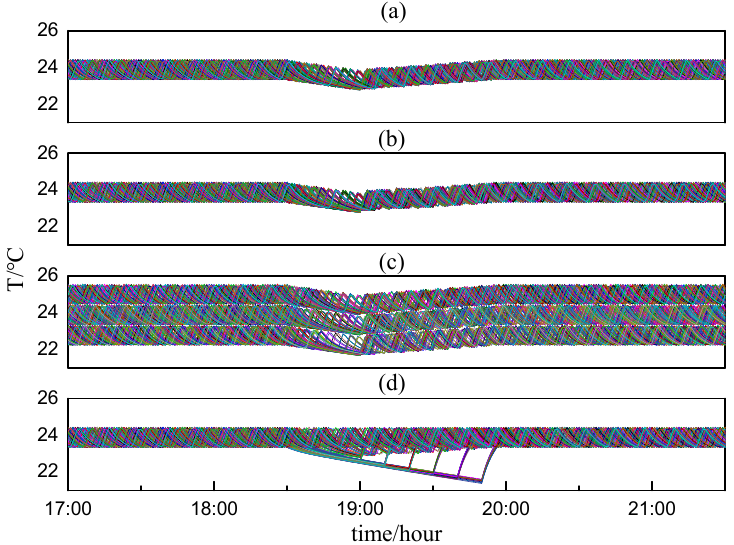
Figure 13. The indoor temperature curves of 200 units randomly selected from the aggregated units; ( a ) represents the first scenario, ( b ) represents the second scenario, ( c ) represents the third scenario, and ( d ) represents the queuing method.